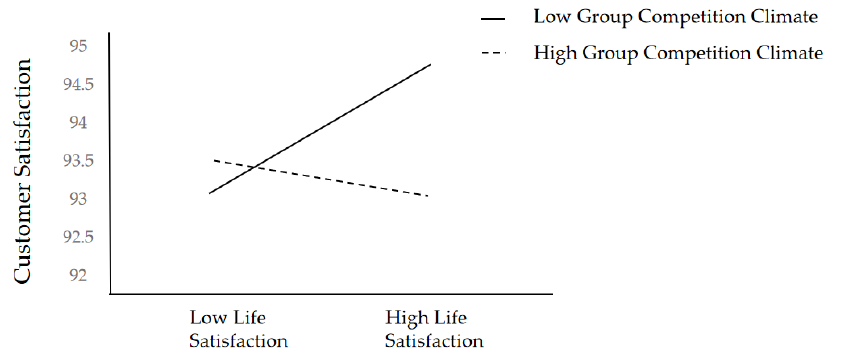
Figure 2. Group Competition Climate Moderating the Indirect Relationship Between Life Satisfac- tion and Customer